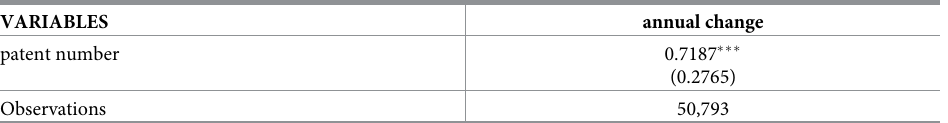
Table 2. Firm size and annual change of